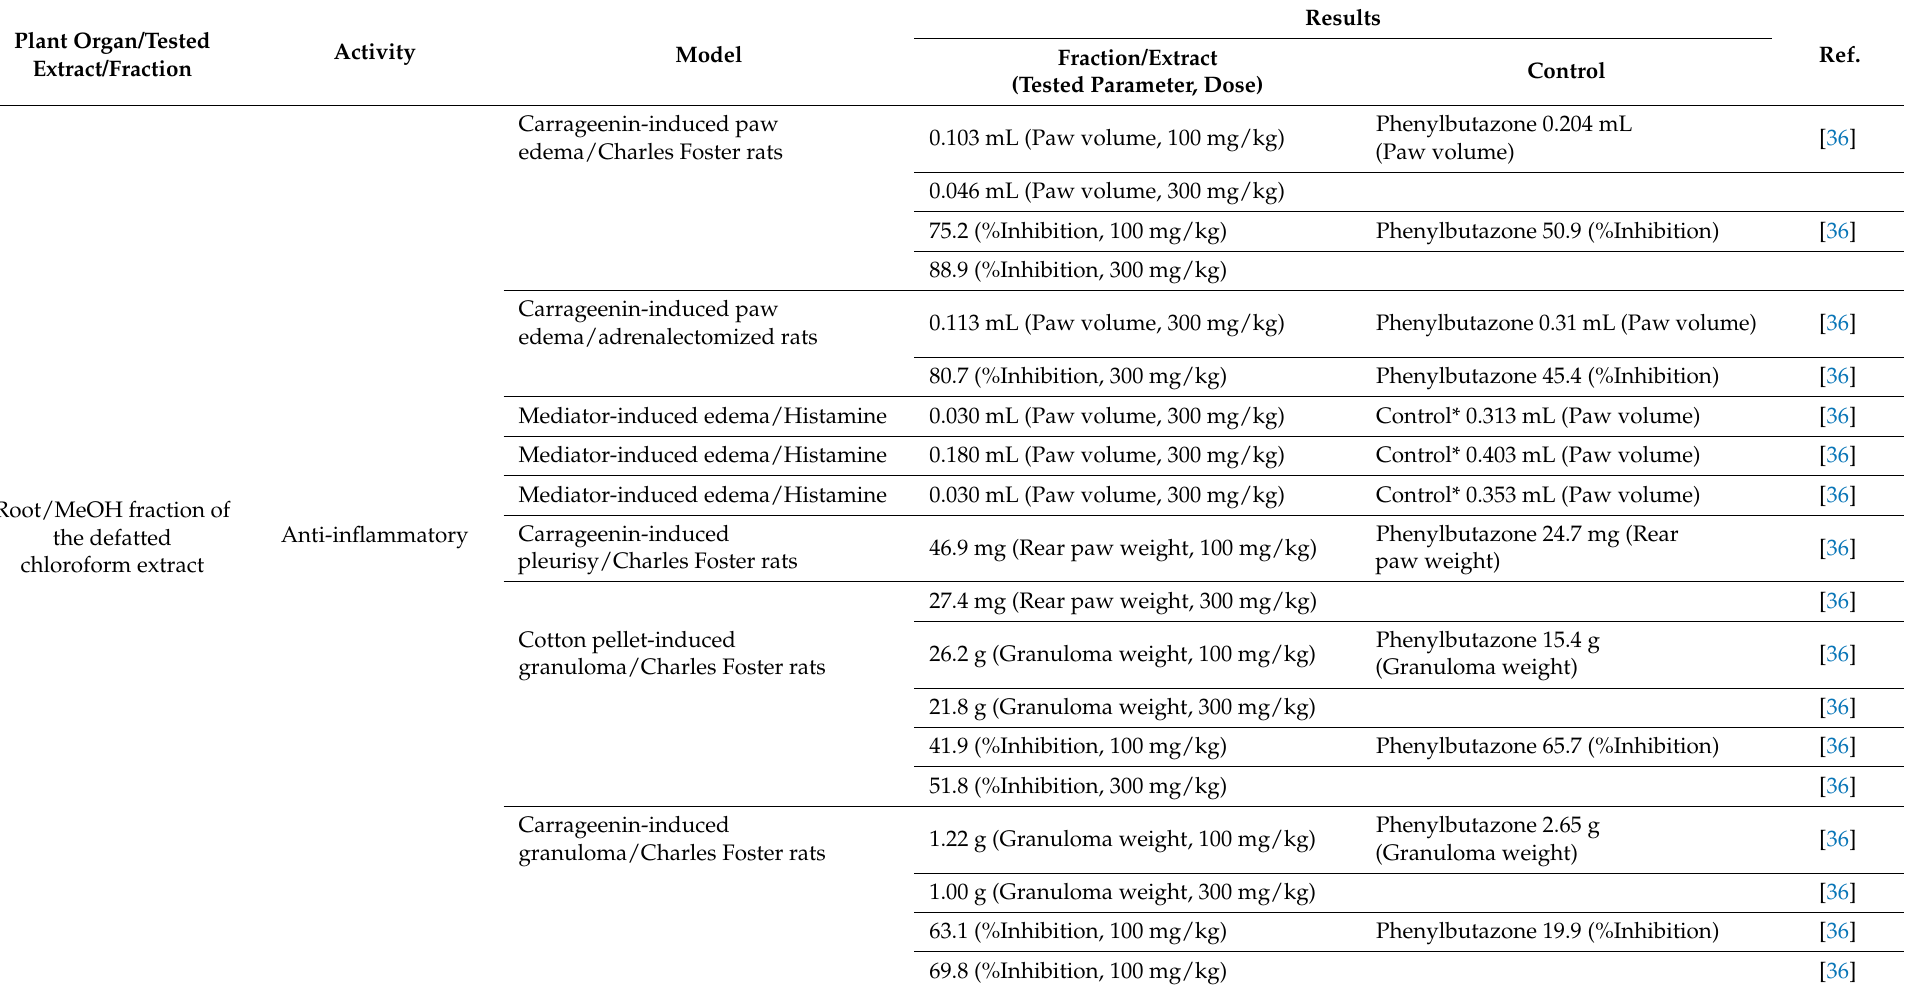
Table 2. Biological activities results of extracts and/or faction of P. indica